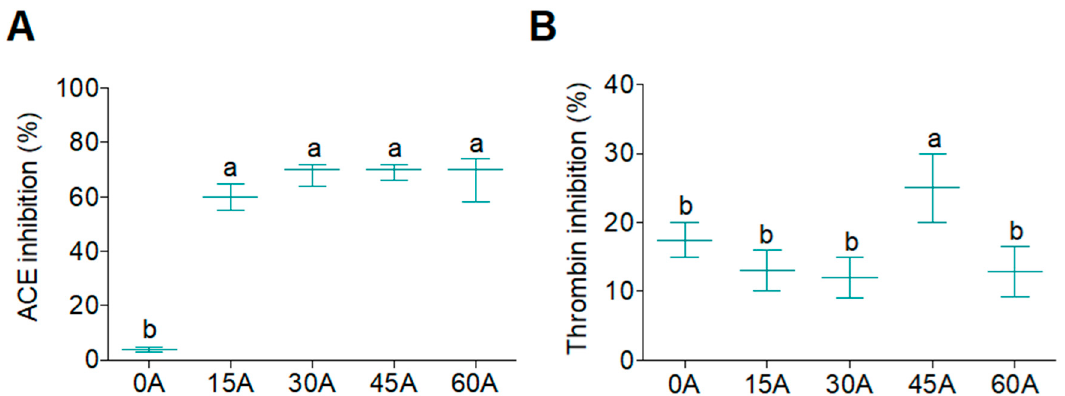
Figure 2. Inhibition of the angiotensin-converting enzyme (ACE) ( A ) and thrombin ( B ) activity by WGPHs performed using Alcalase in cell-free in vitro experiments. Data are showed as means ± SD ( n = 3) and those marked with different letters are significantly different ( p < 0.05).